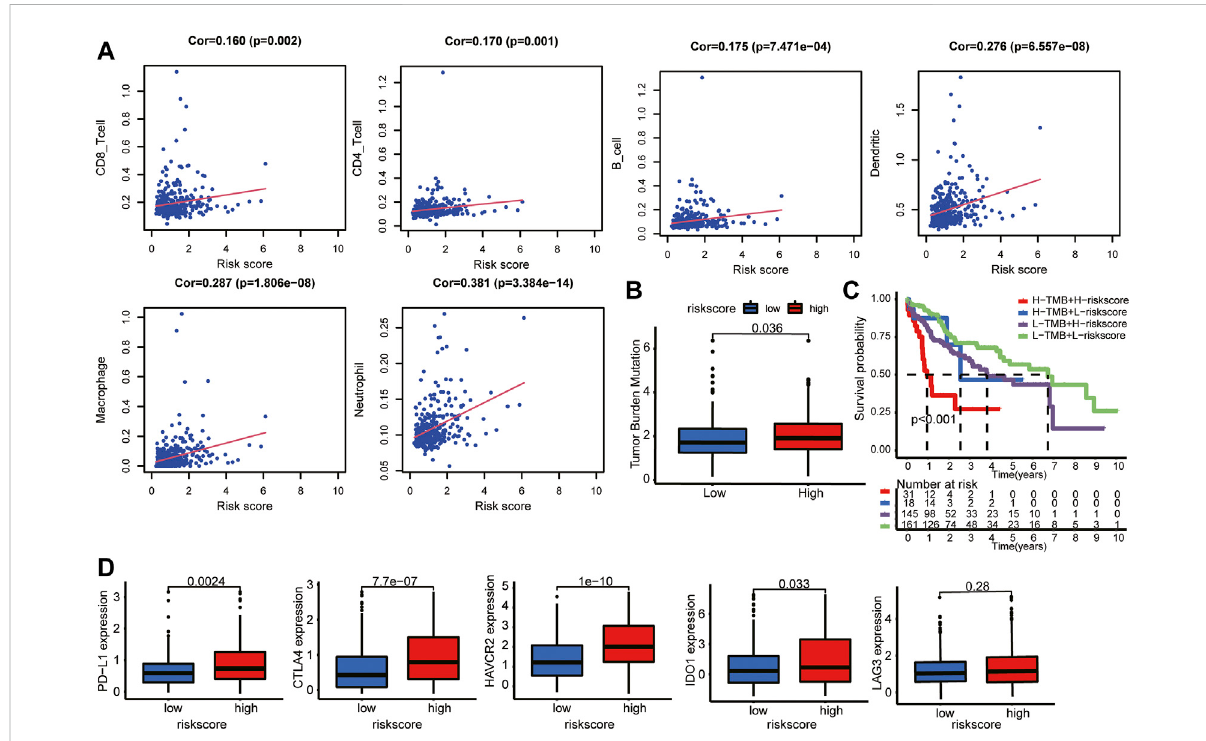
FIGURE 9 Distant immune features in two risk subgroups. (A) The correlation between the risk score and the immune cell in fi ltration. (B) Tumor mutation burden was compared with the two risk subgroups. (C) The risk model still impacted OS in the background of similar TMB scores. (D) Relation between risk score and expression level of immune checkpoint